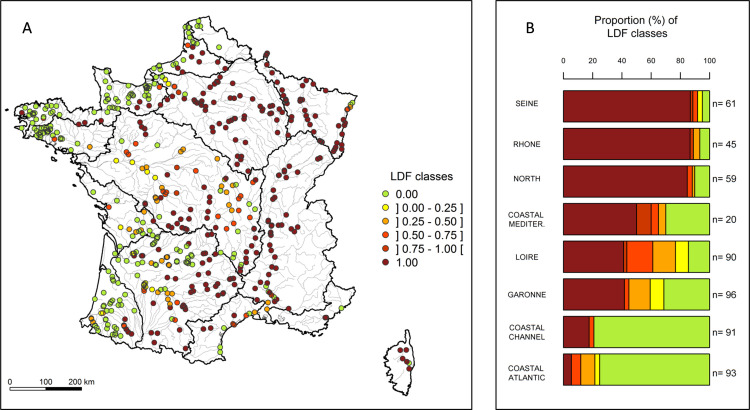
LDF classes per site (A) and proportions (%) of classes per basin (B). ‘n’ corresponds to the number of sites considered in each basin.